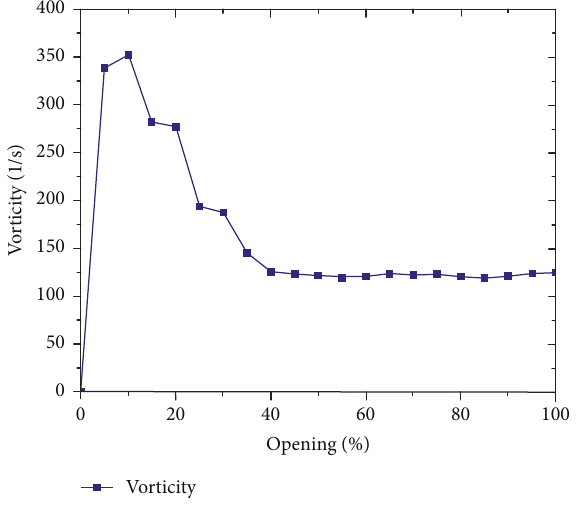
Figure 21: Vortex volume